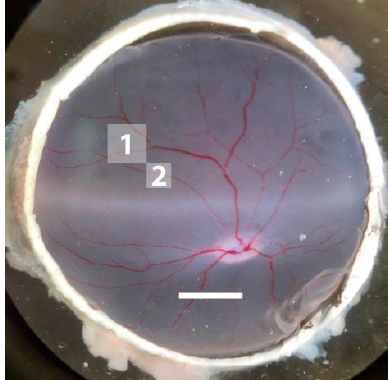
Figure 6. Representative photograph of a pig retina. The marked area labeled with “1” has been used for staining of cells using DAPI and an antibody directed against Brn3a. Just from the area below marked with “2” tissue for histological analysis was taken. Scale bar = 5 mm.